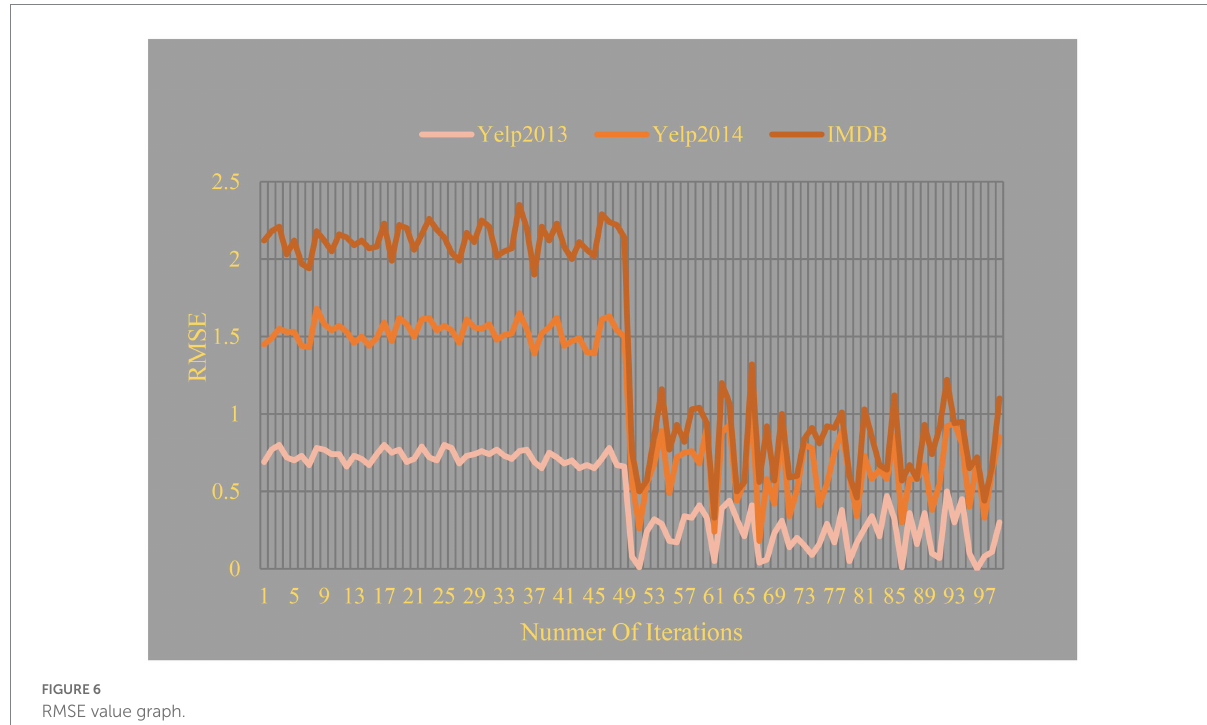
FIGURE 6 RMSE value graph.